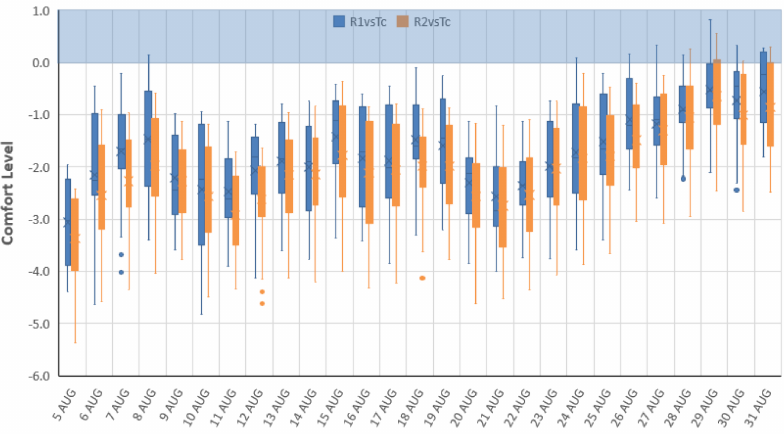
Figure 21. Rooms temperatures as compared to comfort temperature over the experiment